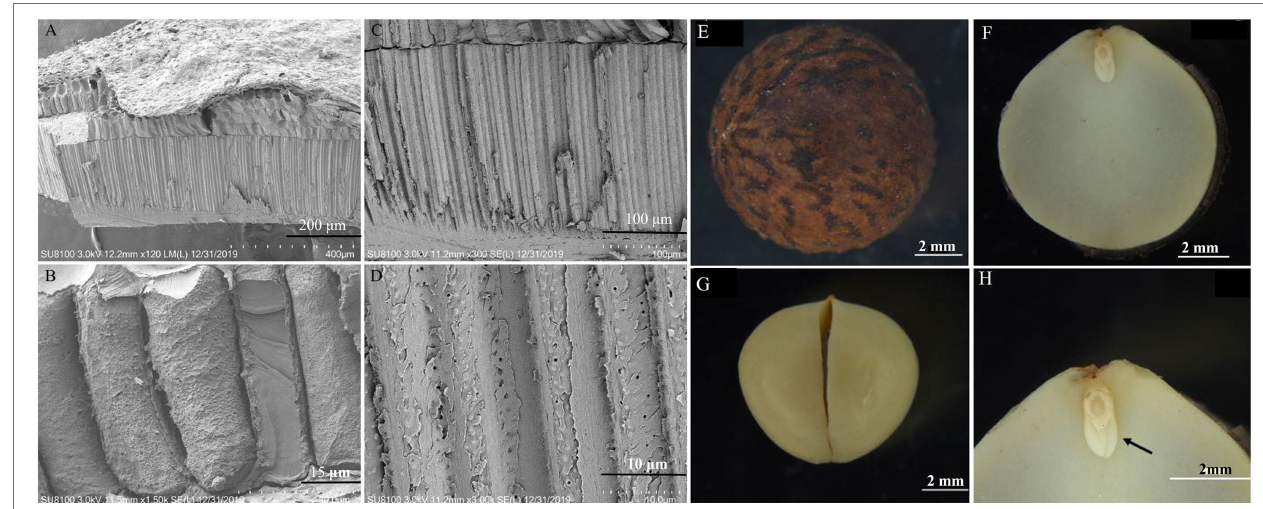
FIGURE 2 | Morphology and anatomy of the Cinnamomum migao seed embryo and endocarp. Scanning electron microscope images of the endocarp (A–D) , scale bar: 2 mm. Light microscope images of the dry seed (E) , embryo (F) , cotyledon (G) , plumule (arrow), hypocotyl, and radicle (H)